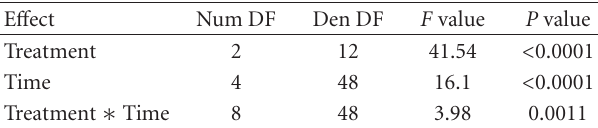
Figure 1: Temporal dynamics of total VOC emissions from cotton bolls exposed to Euschistus servus and Nezara viridula and unexposed (control) bolls under field conditions. Data points represent mean VOC emissions ( ± 1 SE; n = 5). Di ff erent letters indicate a significant di ff erence in total VOC emissions between treatments at each sampling interval (repeated measures ANOVA P < 0 . 05). Table 1: Repeated measures analysis of variance on total volatile emissions released from cotton bolls exposed to Euschistus servus and Nezara viridula and unexposed bolls collected over a 4 d feeding